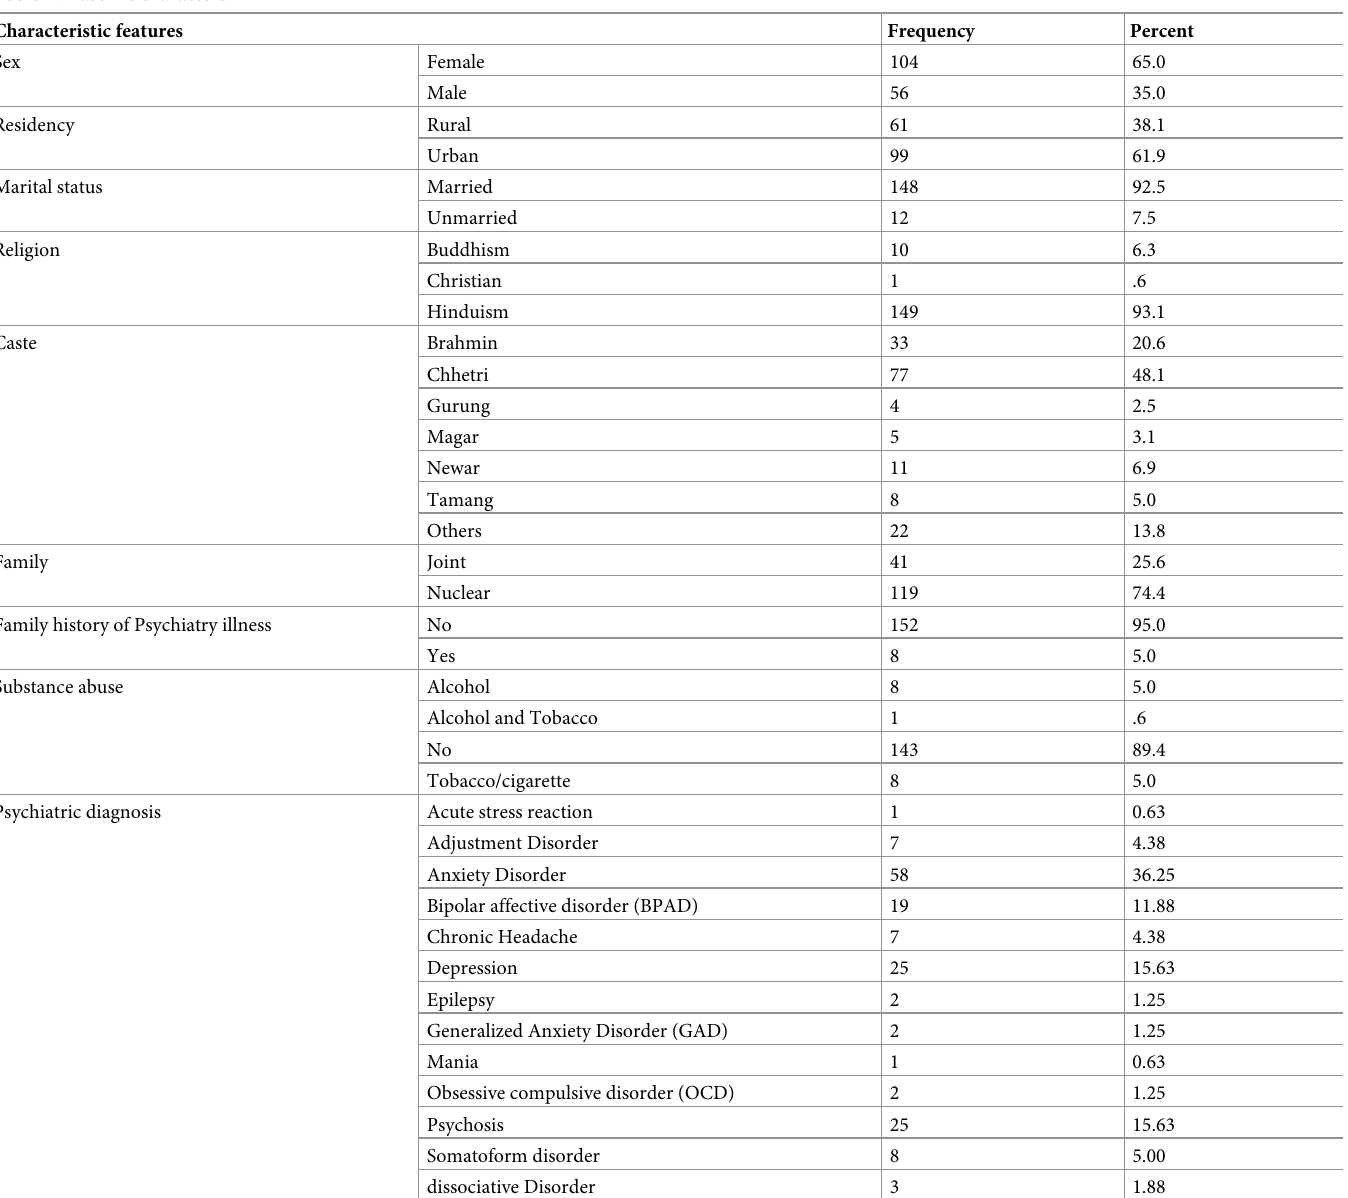
Table 1. Baseline